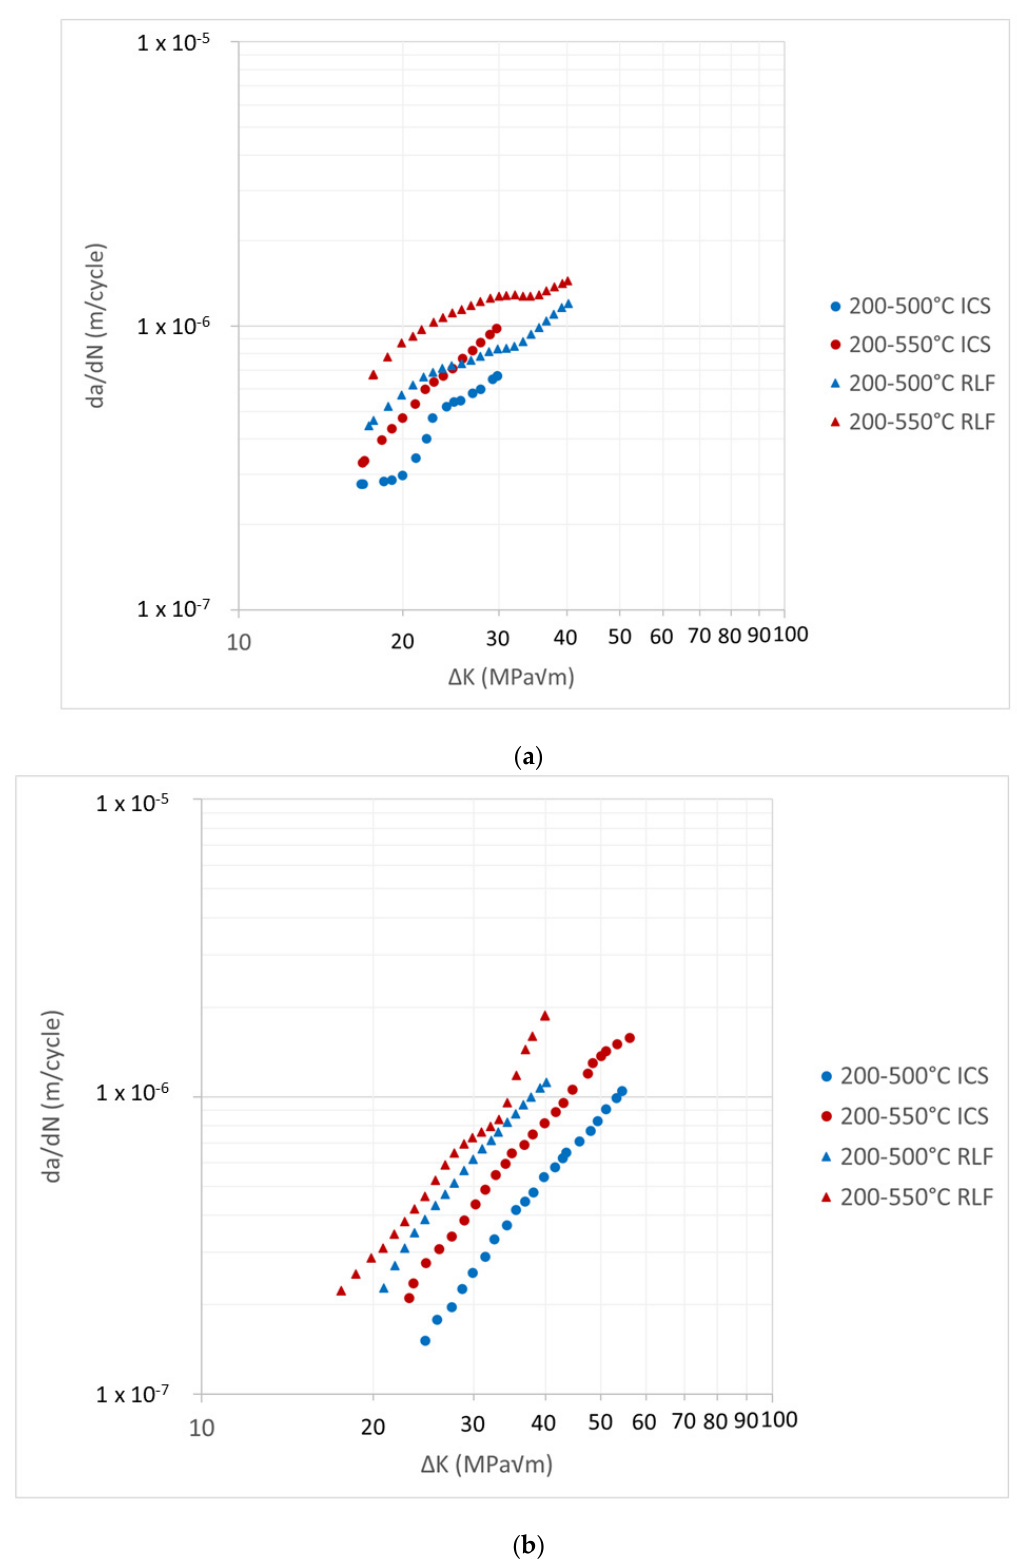
Figure 8. Paris curves comparing TMFCG ( a ) IP and ( b ) OP, using an ICS and RLF. Under both IP and OP conditions, the results are comparable and within reasonable